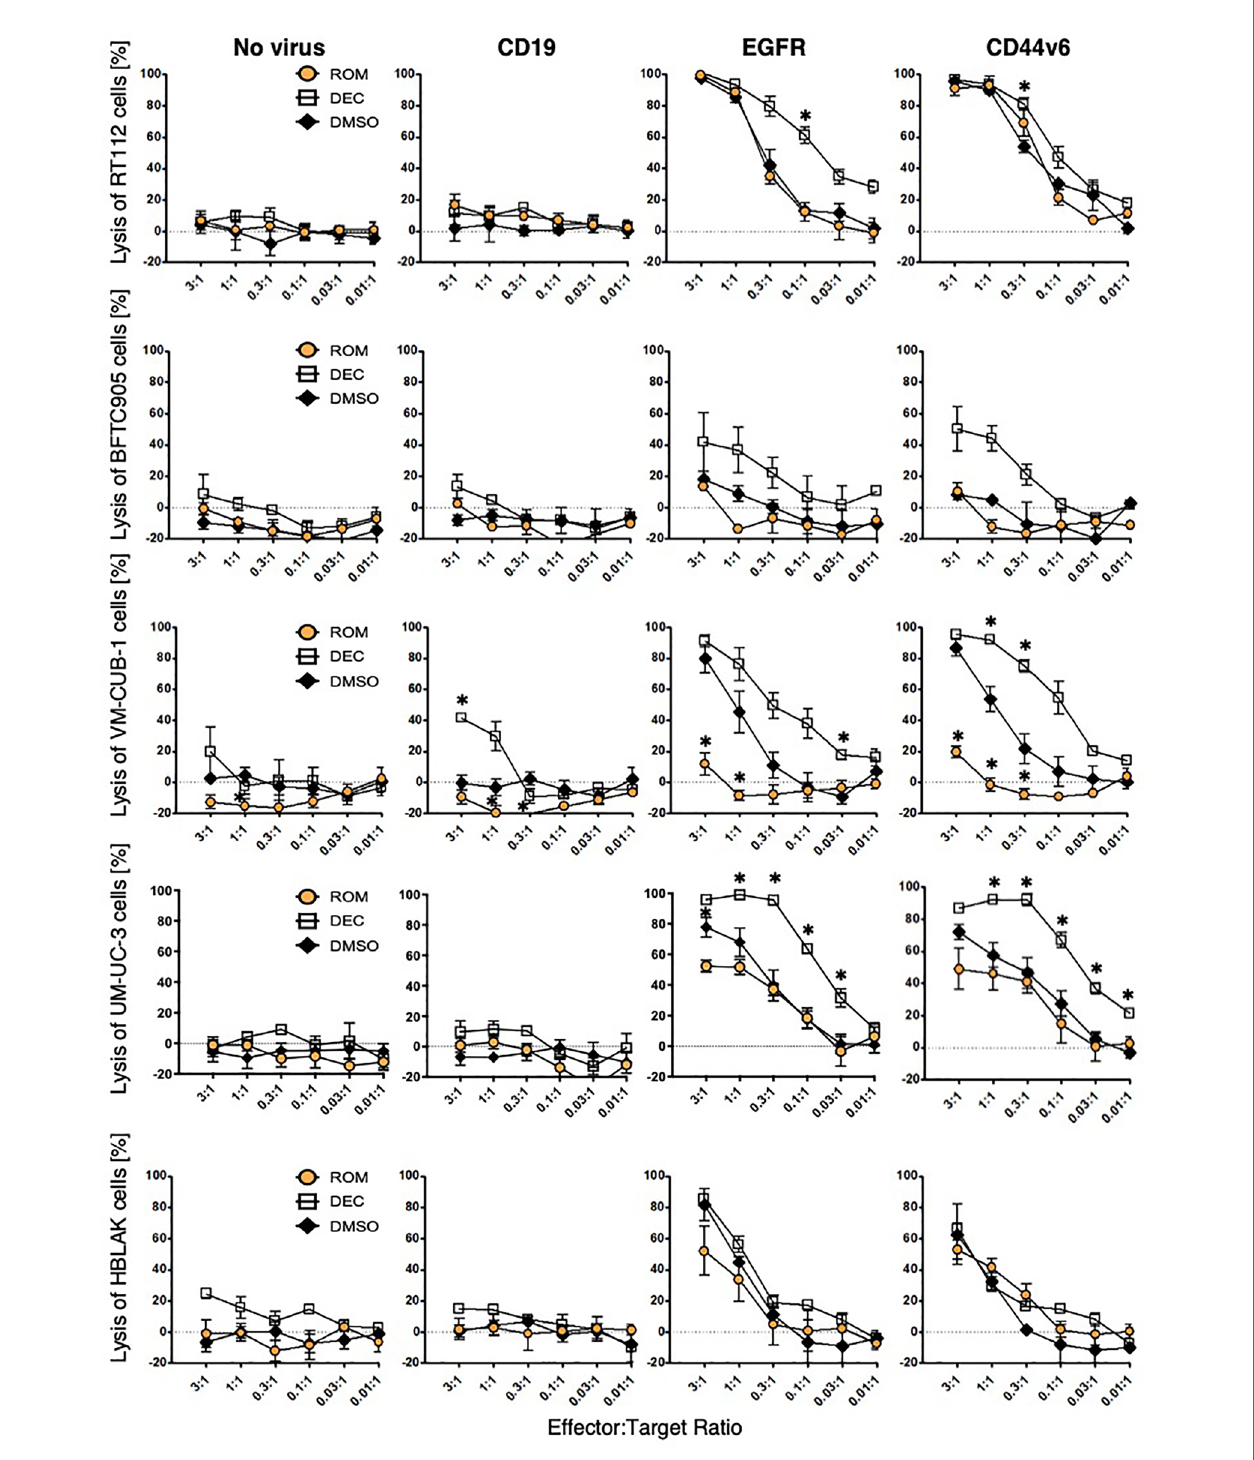
FIGURE 3 | CAR T-cell cytotoxicity can be modulated by epigenetic treatment. UCC and HBLAK cells were pretreated with 100 nM decitabine (white square), 3 nM romidepsin (orange circle), or DMSO (black rhombus) and subsequently co-cultured with CD19-, EGFR-, or CD44v6 CAR T-cells or untransduced (no virus) T-cells. After 16 h co-culture, lysis was determined by MTT assay. Graphs depict the mean values ( ± SD) for percentage of lysed cells from at least three independent experiments. Statistical signi fi cance (p-value <0.05) is denoted by asterisk and was determined by two-way ANOVA and Dunnett ’ s correction for multiple